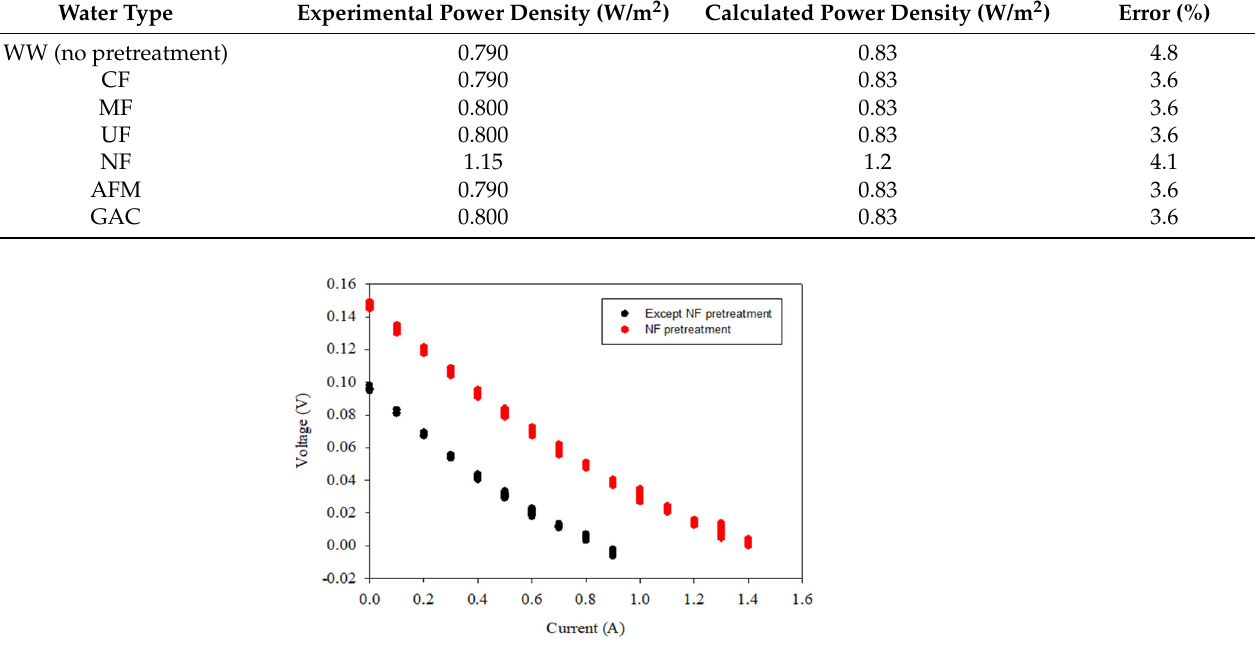
Figure 5. V–I curve according to the RED operation (the operation conditions are except NF pretreatment and NF pretreatment each). Table 7. Power density in RED using raw feed water (WW) and pretreated water.